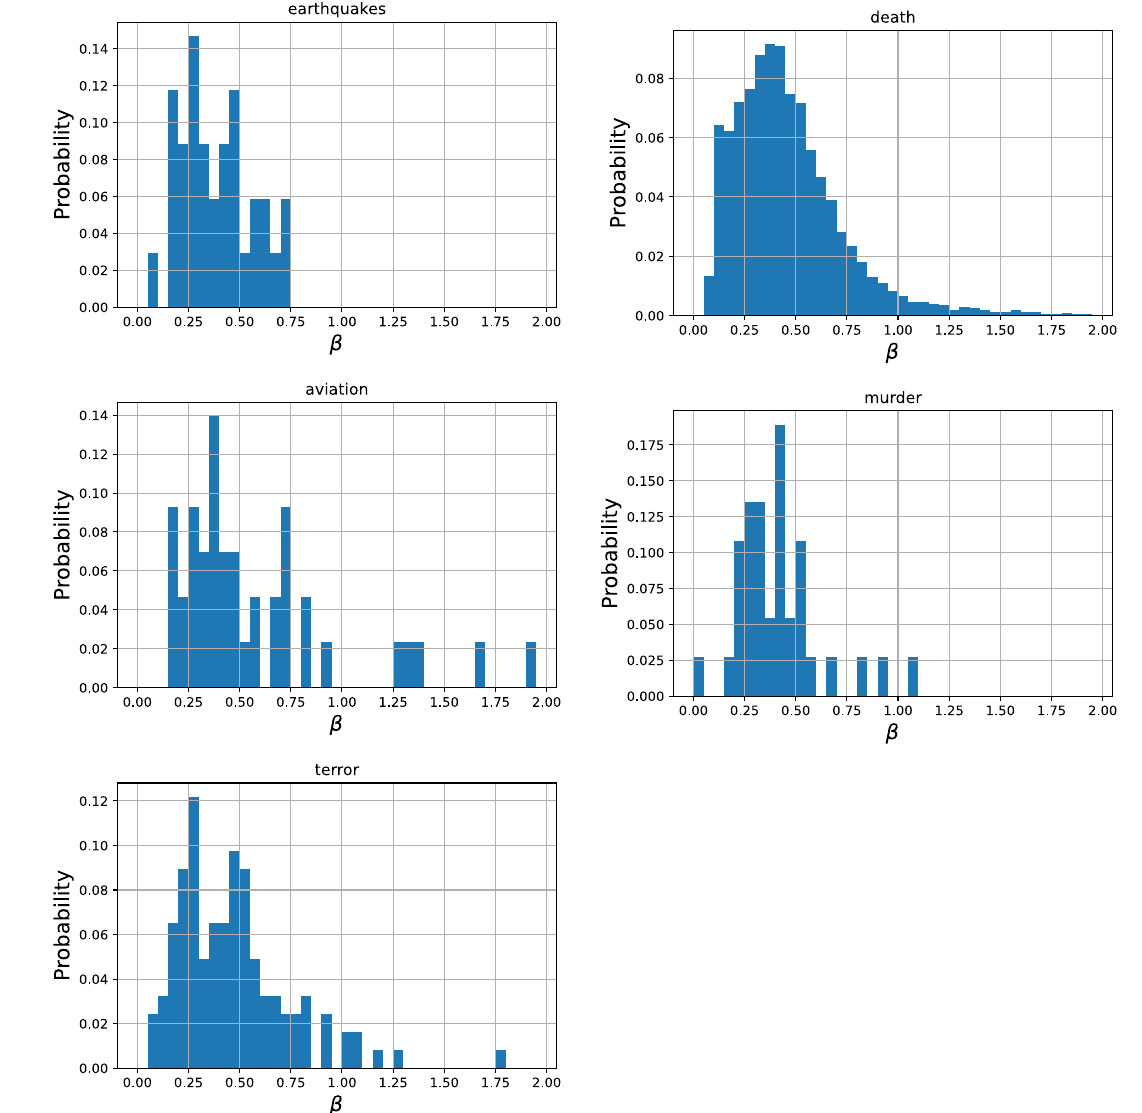
Figure 5. Probability density distributions of parameter values of β obtained using the proposed model in five categories. Most of the samples fall within a certain range ( 0 < β < 2 ) and show similar values ( β ∼ 0.4 ) independent of the category.